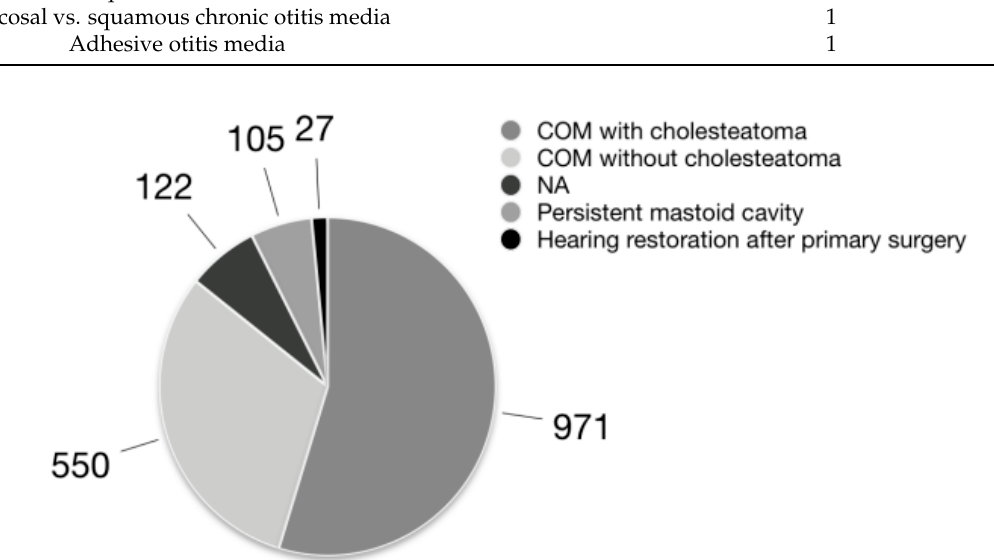
Figure 2. Patient distribution according to the indications for surgery. COM: chronic otitis media; NA: not available.